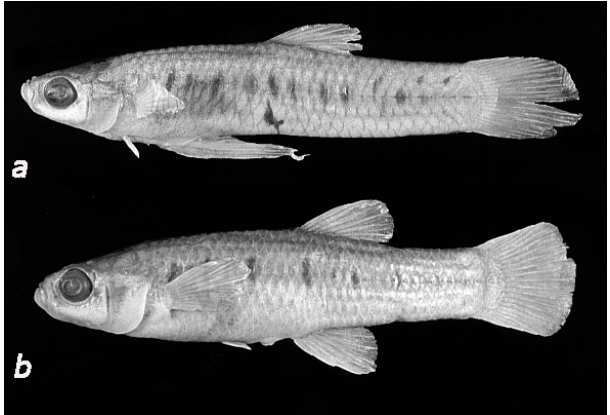
Fig. 9. Cnesterodon brevirostratus . MCP 26050, São José dos Ausentes, Rio Grande do Sul, Brazil: (a) male, 25.2 mm SL; (b) female, 33.7 mm SL.